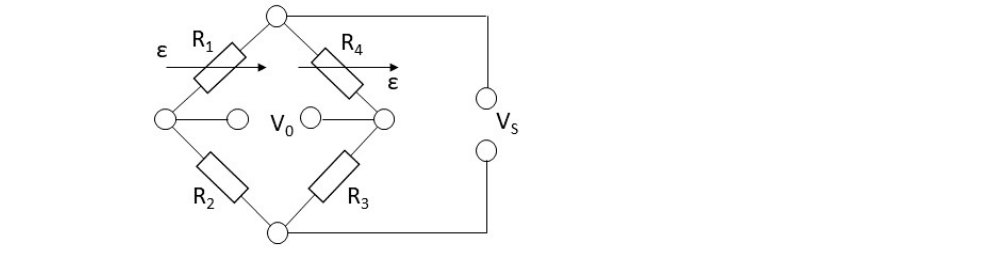
Figure 4. Wheatstone bridge circuit diagram. Half-bridge configuration. Vs: input voltage. Vo: output voltage. Ri: resistance i. ε : indicates which resistances represent strain gauges.